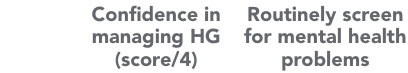
Table 1 Relationship between additional qual- ifications or training and confidence levels and likelihood of screening for mental health conse- quences in Nana M et al . BJGP Open 2021; DOI: 10.3399/BJGPO.2021.0119